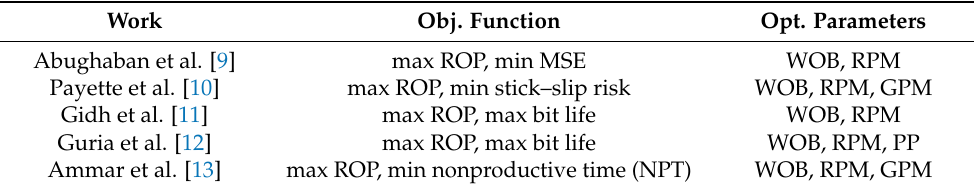
Table 1. Related works of multi-objective optimization of drilling parameters.